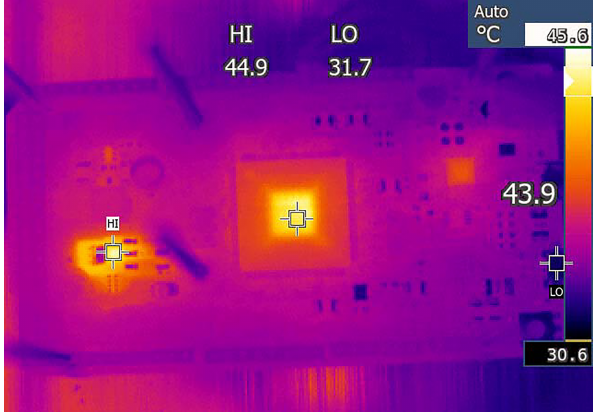
Figure 5. Thermal image of the Arduino Due during